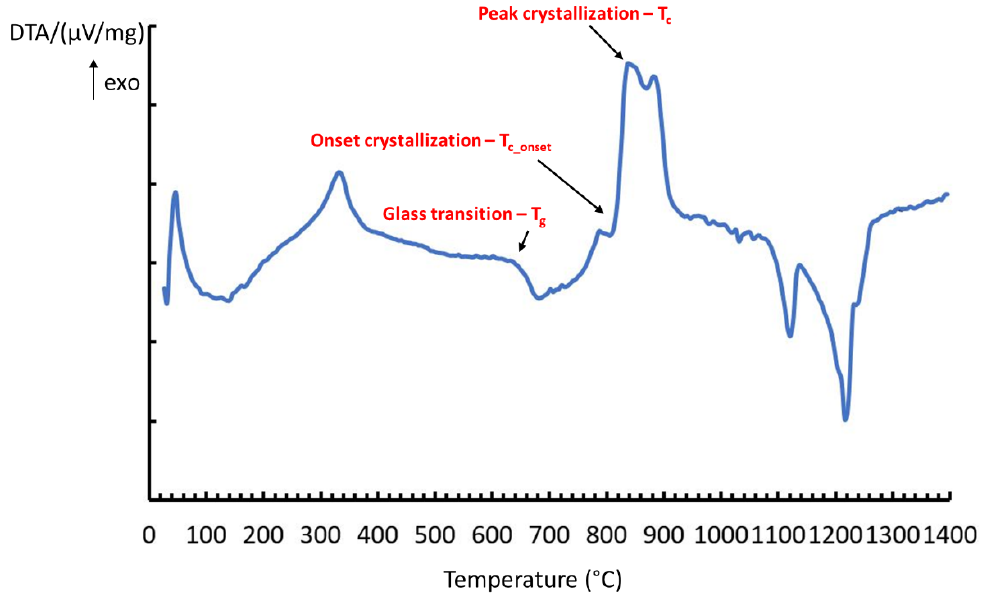
Figure 1. Di ff erential thermal analysis (DTA) curve of BGMSN Figure 1. Differential thermal analysis (DTA) curve of BGMSN powders.